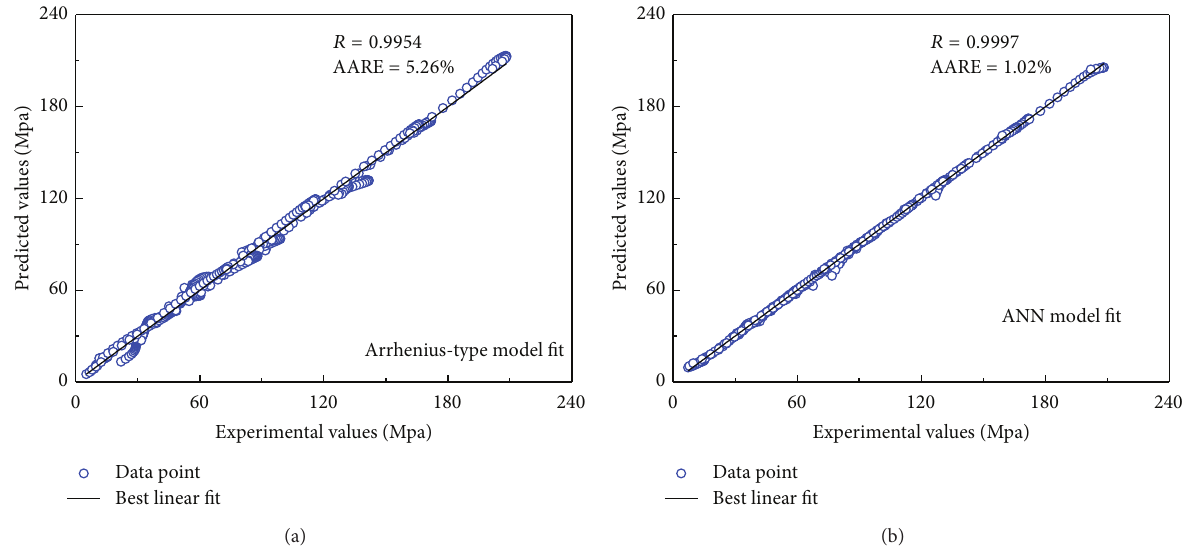
Figure 9: Correlation between experimental and predicted flow stress data from (a) constitutive model and (b) ANN model.